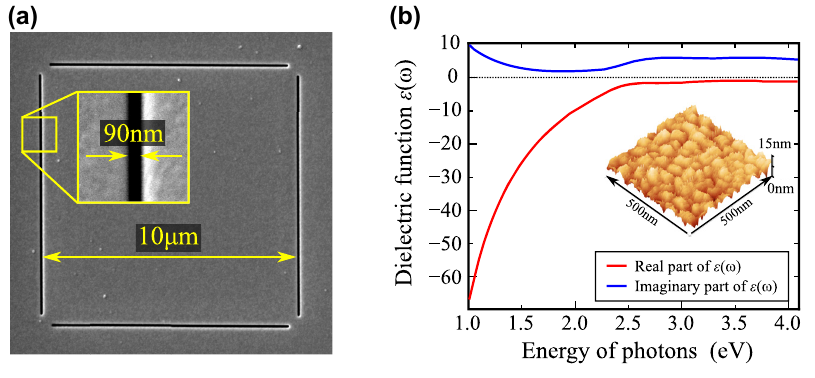
Figure 8: Fabrication of samples. (a) SEM imageofthesquare-likeSPID.(b)Ellipsomet- ric measurement of the complex dielectric function for the 200 nm thick gold layer on substrate deposited by IBS technique. SiO 2 The topography of the deposited layer was measured using AFM revealing maximum surface roughness of less than 15 nm and grain size of approximately 50 nm.